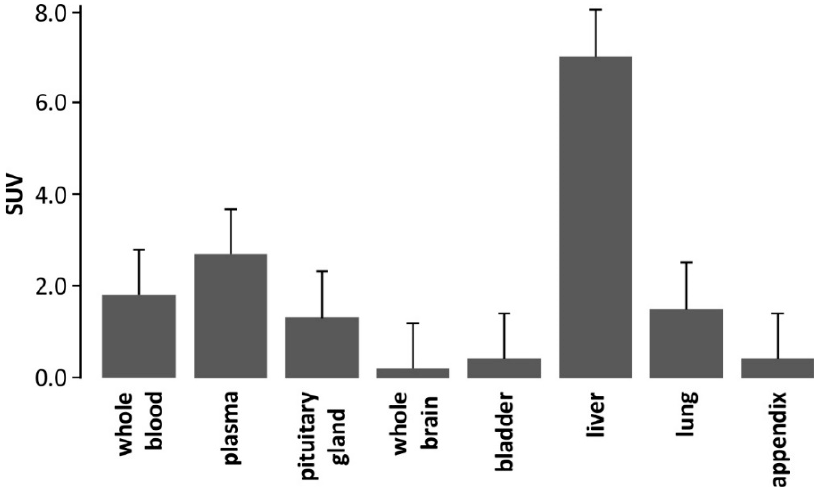
Figure 2. Organ distribution of [ 3 H]PSB-603 in mice at 3 min p.i. (data are presented as mean values ± SD; n = 3).